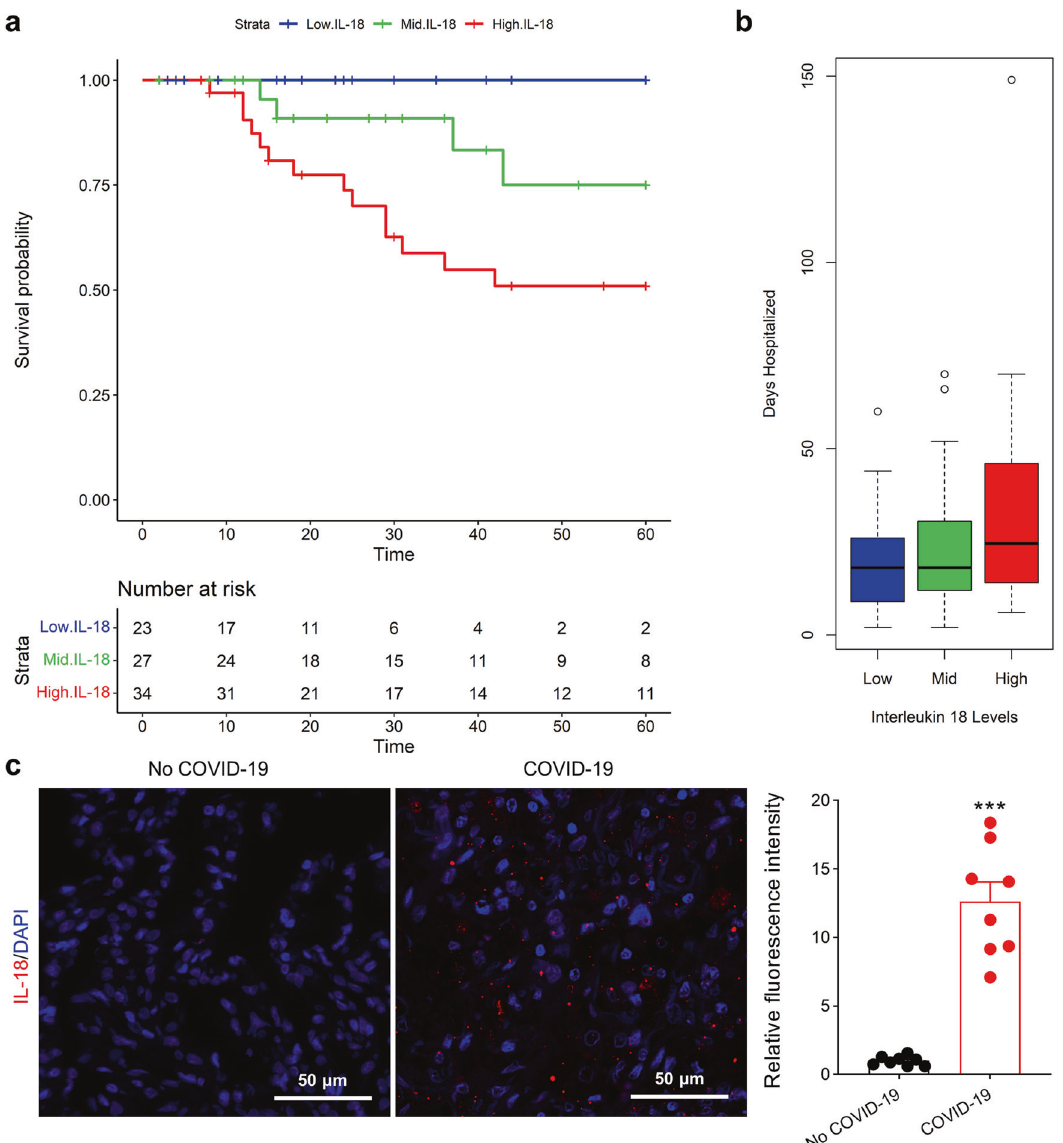
(discharge or death). There was worse survival if IL-18 levels were high (red, above cutoffs of 102 pg/mL versus green, 48.6 – 102 pg/mL versus blue, below cutoffs of 48.6 pg/mL). Each line indicates the predicted survival probability over follow-up time. b Boxplot of IL-18 tertiles and days spent hospitalized is plotted. c IL-18 fl uorescence microscopy of human lung from COVID-19 patients vs. non-COVID-19